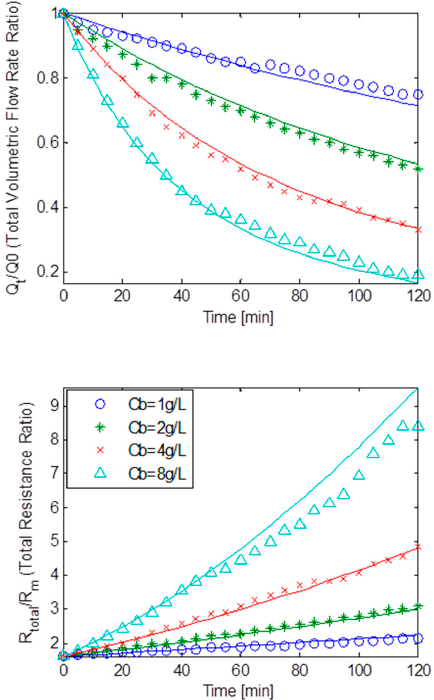
Figure 7. Flux decline and total resistance data obtained from Duclos-Orsello et al . [15] with best model fits.